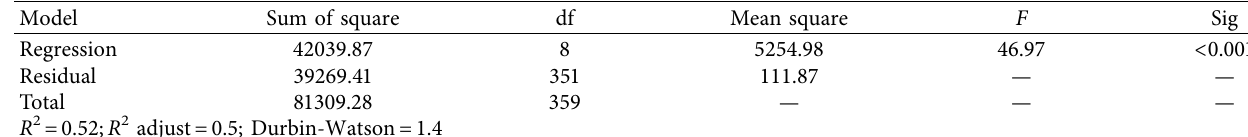
Table 5: ANOVA table.